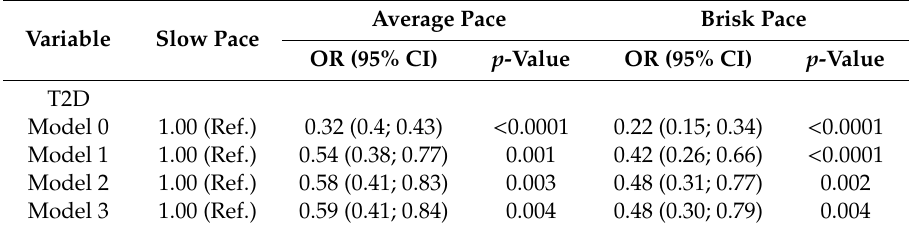
Table 3. Association between walking pace and Type 2 Diabetes (T2D).